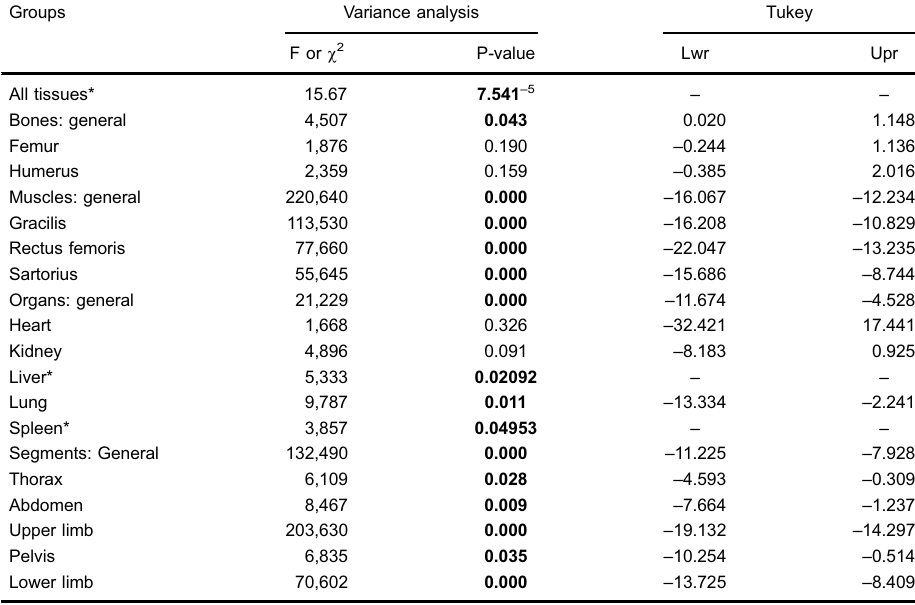
Table 3. Tissue or segment shrinkage values tested with P1 and S10 silicones.